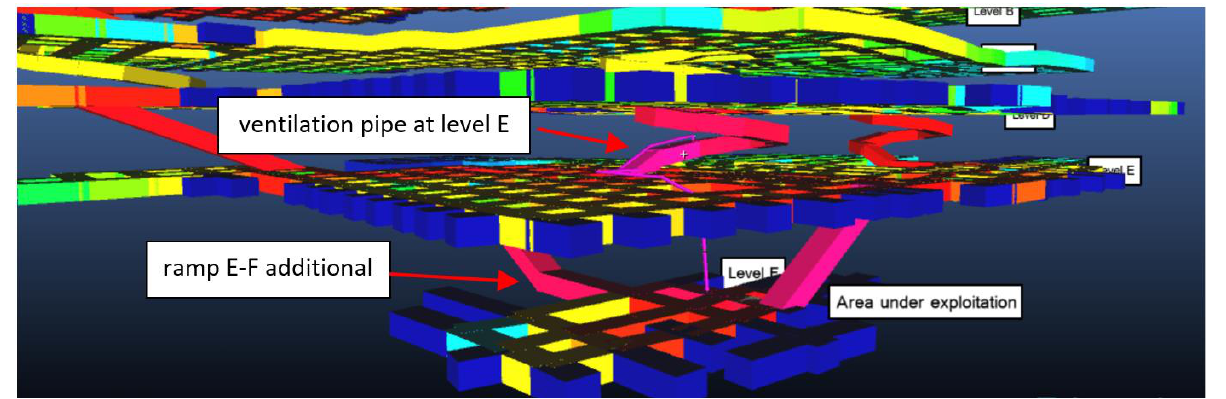
Figure 3. View of the numerical model developed to study the effect of fires inside the Murisengo underground quarry (Case A: current situation). The different levels (from A to F), the main heli- cal ramps (S. Pietro and Prato Nuovo), the connecting ramp between Levels E and F (E – F ramp), and the shaft with the main fan of the mine. The two areas where the fire was hypothesized (green which were obtained from the combination of Cases 1 and 2, and Cases A and B, thus: A1, points) are also shown: (1) at Level F and (2) on the connecting ramp between Levels D and E. A2, B1, and B2.